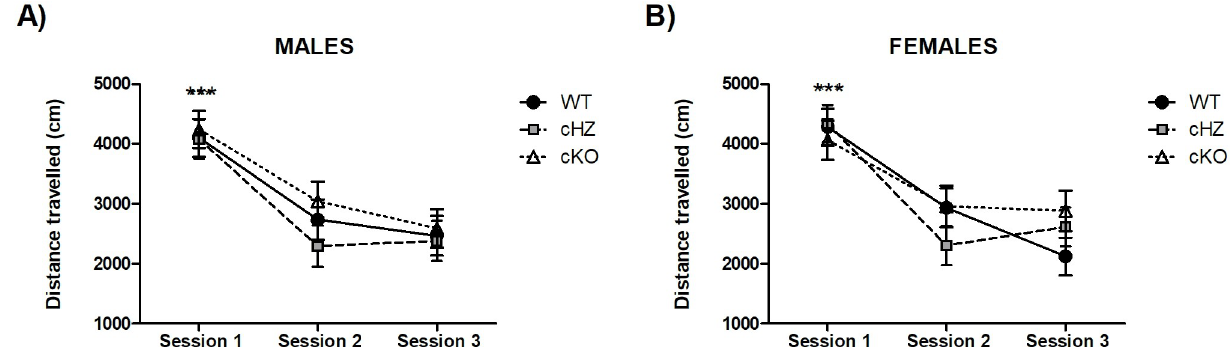
Fig 3. Locomotor activity: ACT. The lines represent the distance in centimetres travelled by the mice during the 60-minute session (Mean and SEM). The measure was acquired in three consecutive sessions, comparing the groups WT ( Grik4 Cre+/+ , SV2A lox/lox ), cHZ ( Grik4 Cre+/- , SV2A lox/+ ), and cKO ( Grik4 Cre+/- , SV2A lox/lox ). Males (n = 22) are presented in subfigure A , whereas females (n = 23) are shown in subfigure B . ( ��� ) indicates that the corresponding marginal mean (main effect of Session ) is significantly different from the other sessions, as yielded by a Bonferroni test taken at p < .001. Note that in cHZ and cKO groups no statistically significant differences were found between the second and the third sessions (all p >